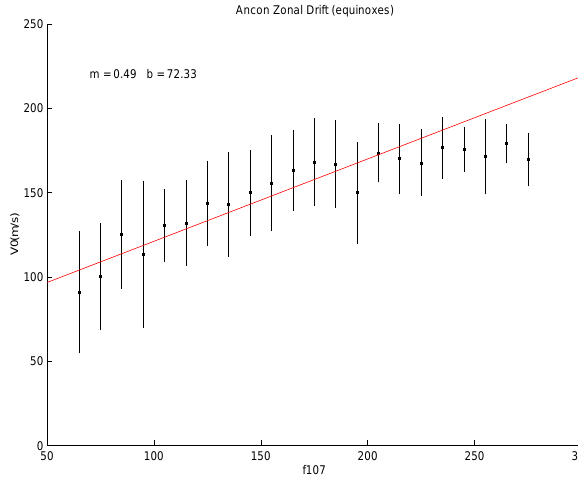
Fig. 11. Linear fit to Ancon zonal drift measurements in 02:00 LT bin vs. solar flux during the equinoxes (all data